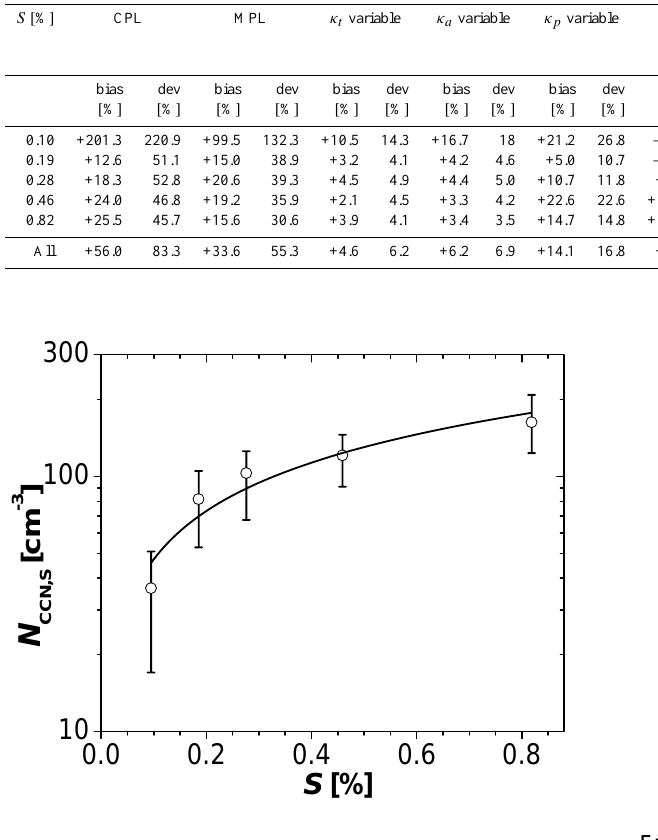
Fig. 9. CCN number concentrations ( N CCN ,S ) observed at different Fig. 9: CCN number concentrations ( N ) observed at different supersaturations ( S = 0.10-0.82%) plotted against Fig. 8. CCN number concentrations ( N CCN ,S ) plotted against wa- CCN, S supersaturations ( S =0.10–0.82%) plotted against the number con- ). The lines are power law fits of the form N = the number concentration of aerosol particles with D >30 nm ( N ter vapor supersaturation ( S ). The data points are median val- CN,30 CCN, S centration of aerosol particles with D > 30nm ( N CN , 30 ). The lines ues, and the error bars extend to lower and upper quartiles for .( s ) -q ; best fit parameters are given in Tab. 5. N ) plotted against water vapor supersaturation ( S ). The data points are Fig. 8: CCN number concentrations ( N CN,30 are power law fits of the form N CCN ,S = N CN , 30 · (s) − q ; best fit pa- CCN, S the entire campaign. The black line is a power law fit of the median values, and the error bars extend to lower and upper quartiles for the entire campaign. The black line is a rameters are given in Table 5. form N CCN ,S = N CCN , 1.( S /(1%)) k with the best fit parameters power law fit of the form N = N .( S /(1%)) k with the best fit parameters N = 201 cm -3 and k =0.63 ( R 2 =0.91, CCN, S CCN,1 CCN,1 N CCN , 1 =201cm 3 and k =0.63 ( R 2 0.91, n =5). n =5). Fair agreement between measured and predicted CCN number concentrations was also achieved when the cam- paign median value of κ ≈ 0.15 was used for the calculation of N CCN ,S,p . With this constant average hygroscopicity param- eter, the mean relative deviations were about twice as high but the bias was not higher than when using variable κ t or κ a values (15%, +4%, Table 4; Fig. 10b). Figure 10c illustrates the